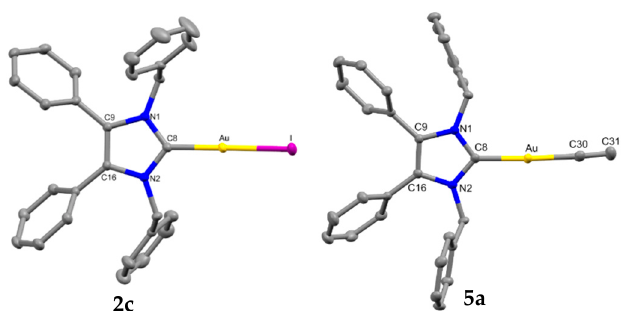
Figure 3. X ‐ ray diffraction structures of NHC* ‐ Au ‐ I ( 2c) and NHC* ‐ Au ‐ CCH ( 5a) ; thermal ellipsoids drawn on the 50% probability level. Solvent molecules and hydrogen atoms have been omitted for clarity.